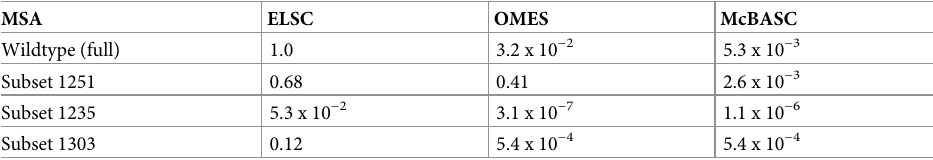
Table 3. Statistical analysis of ELSC, OMES, McBASC